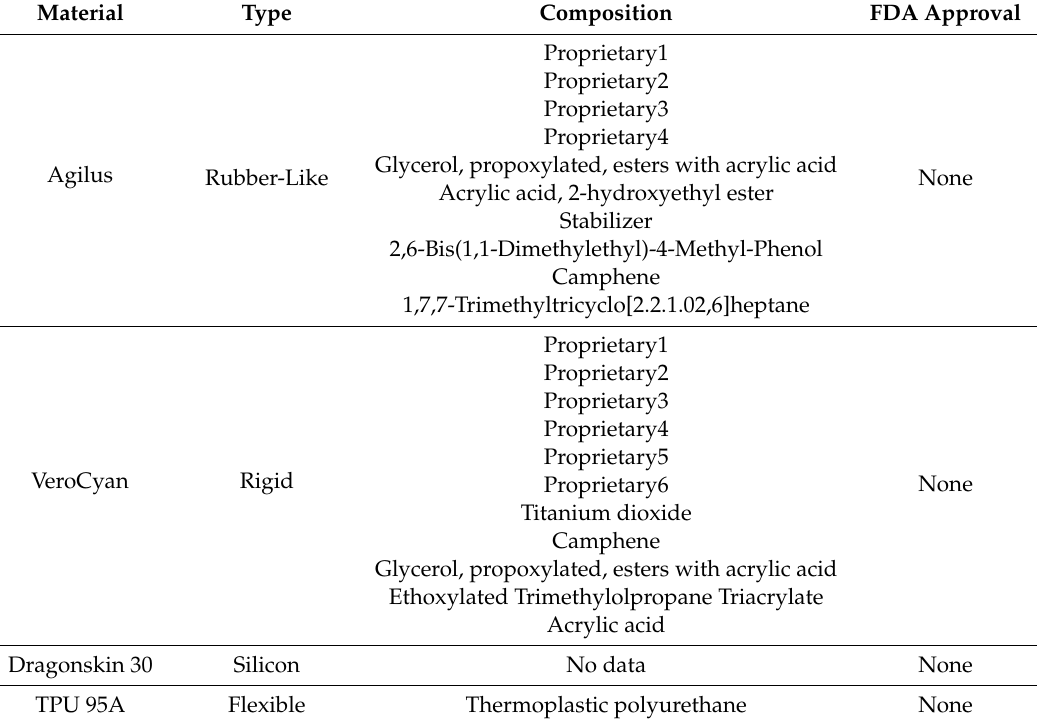
Table 1. Type and composition of materials, Food and Drug Administration approval [32–35].